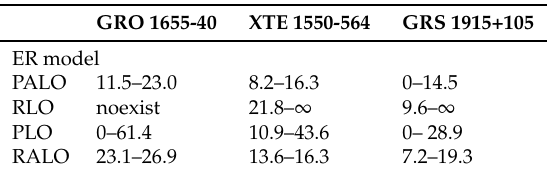
Table 4. Magnitude of the magnetic field in the three microquasars implied by the fitting of the twin HF QPO frequencies. We use combined values for the ER variant of the magnetic modification of the geodesic model related to the 3:2 and 2:3 resonances (Table 3). Numbers in the table are in units of 10 − 5 G for electrons (2 10 − 2 G for protons). ×